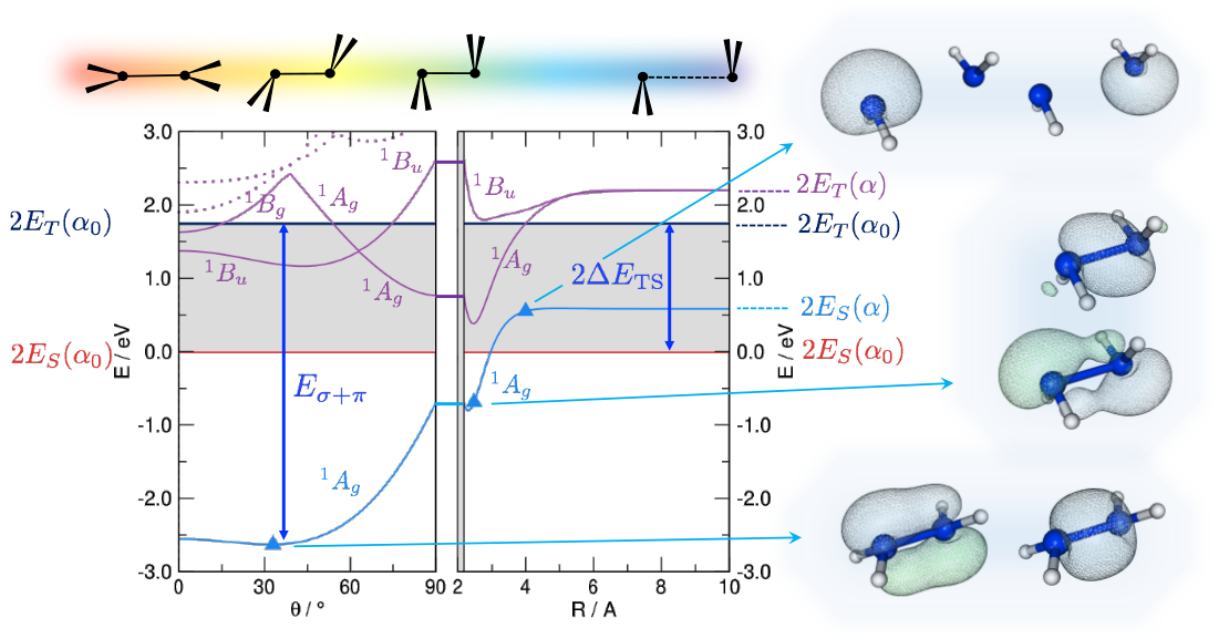
Figure 1. DFT energetics of disilene (H 2 SiSiH 2 ) along the path devised by Trinquier and Malrieu [27], sketched on top of the graphs, along with some important energy values: the triplet-singlet separation ( ∆ E TS ) of the fragments and the strength of the double bond ( E σ + π ). Energy is referenced to the pair of singlet fragments in their equilibrium geometry ( α 0 ). Shown also are the lowest lying singlet excited states (solid and dotted lines in purple), and the relevant (occupied) Natural Bonding Orbitals for selected structures along the path, as